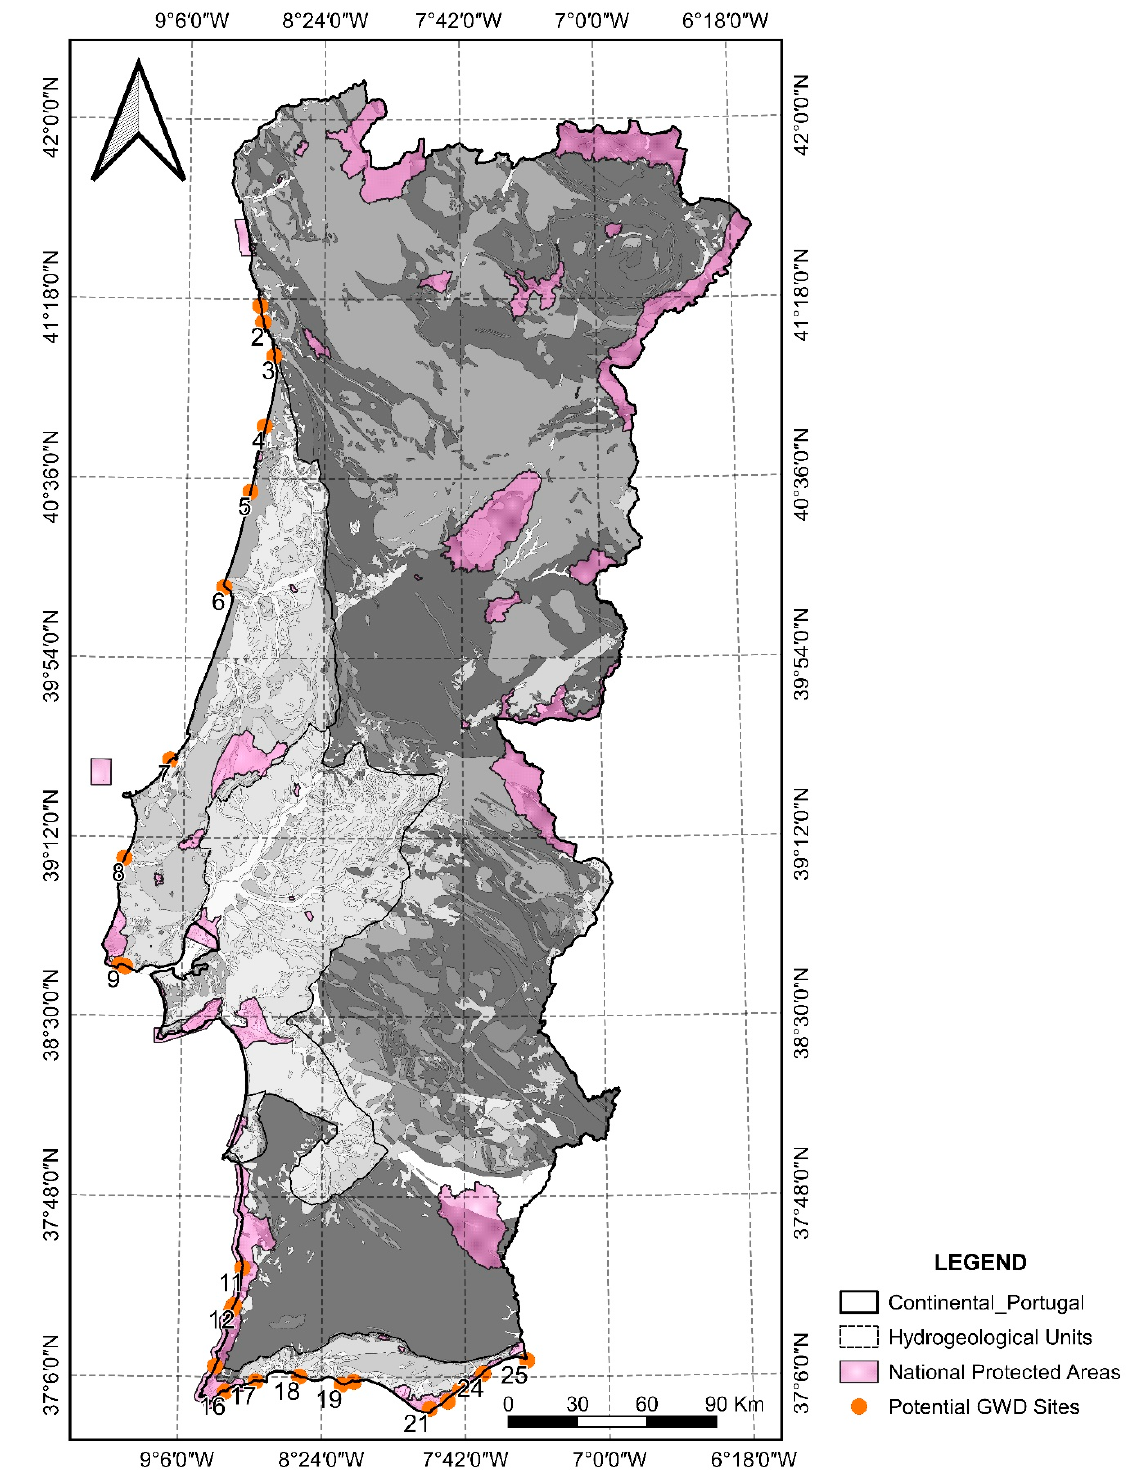
Figure 6. Location of potential sites of groundwater discharge in the Portuguese coastline based on visual inspection of temperature anomalies.